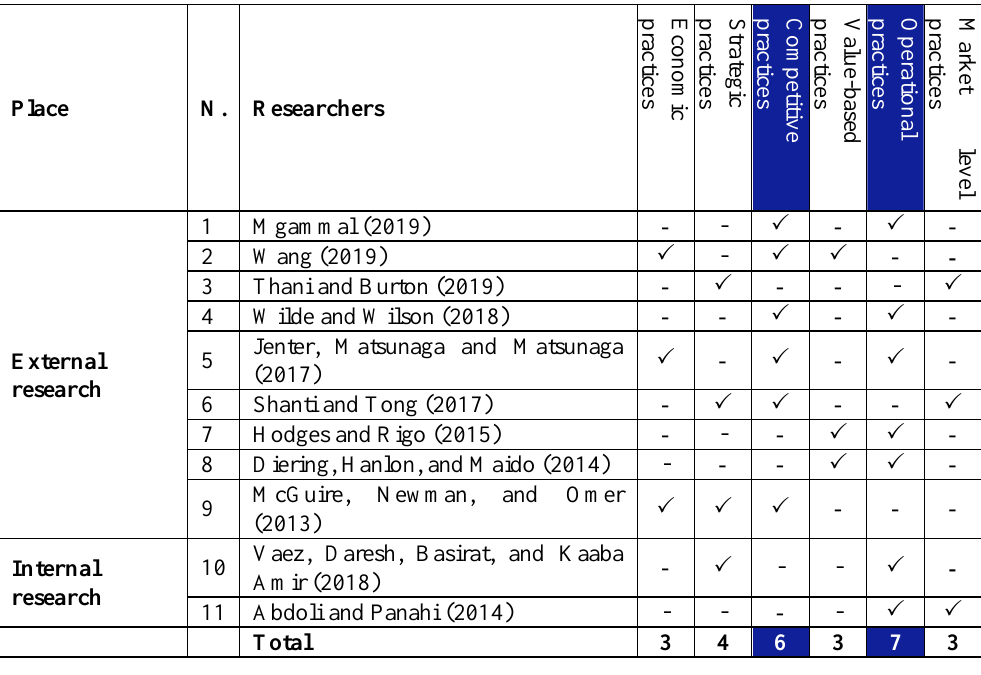
Table 2: Determining the main components of tax consequences under corporate information environment